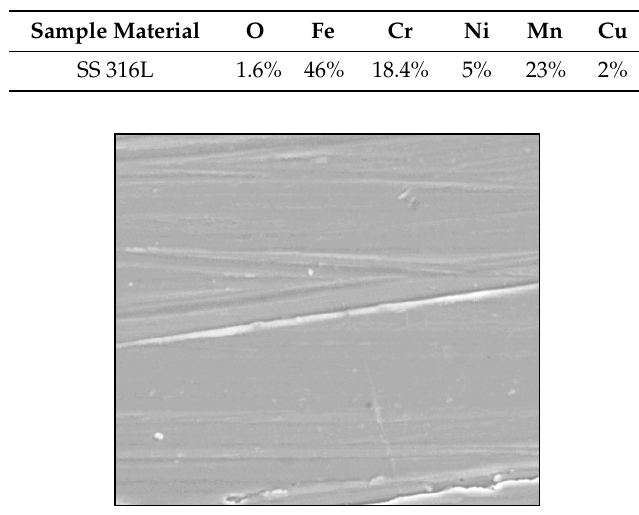
Figure 3. Top-down SEM image of an untested SS 316L sample surface (5000×).